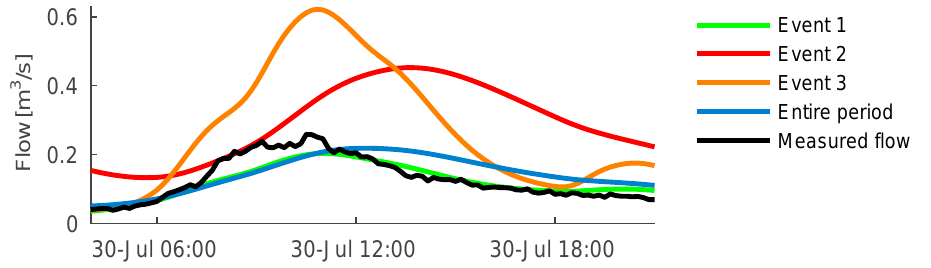
Figure 6. Observed flow for an example event compared to simulations performed with four different model calibrations: three single event calibrations and a calibration using the entire data period.